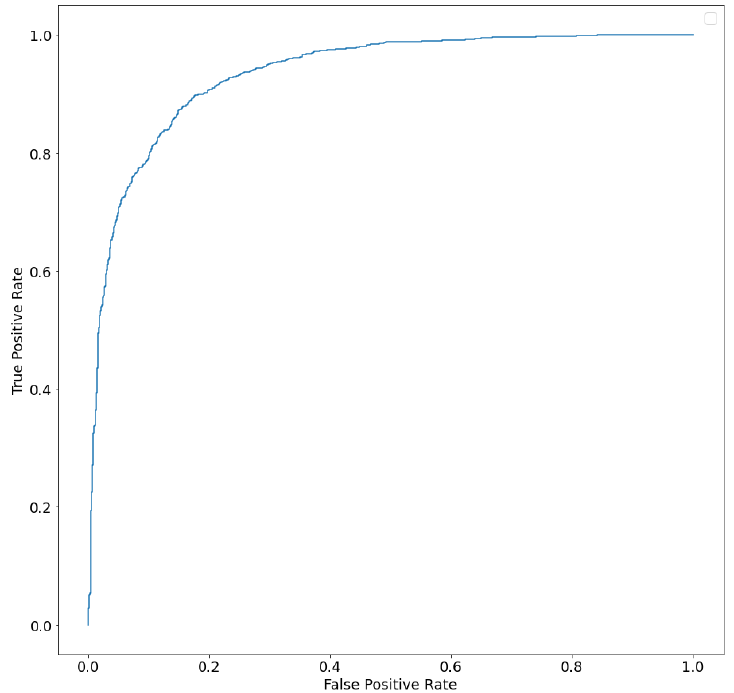
Figure 3. ROC curve (AUC) of ensemble model.